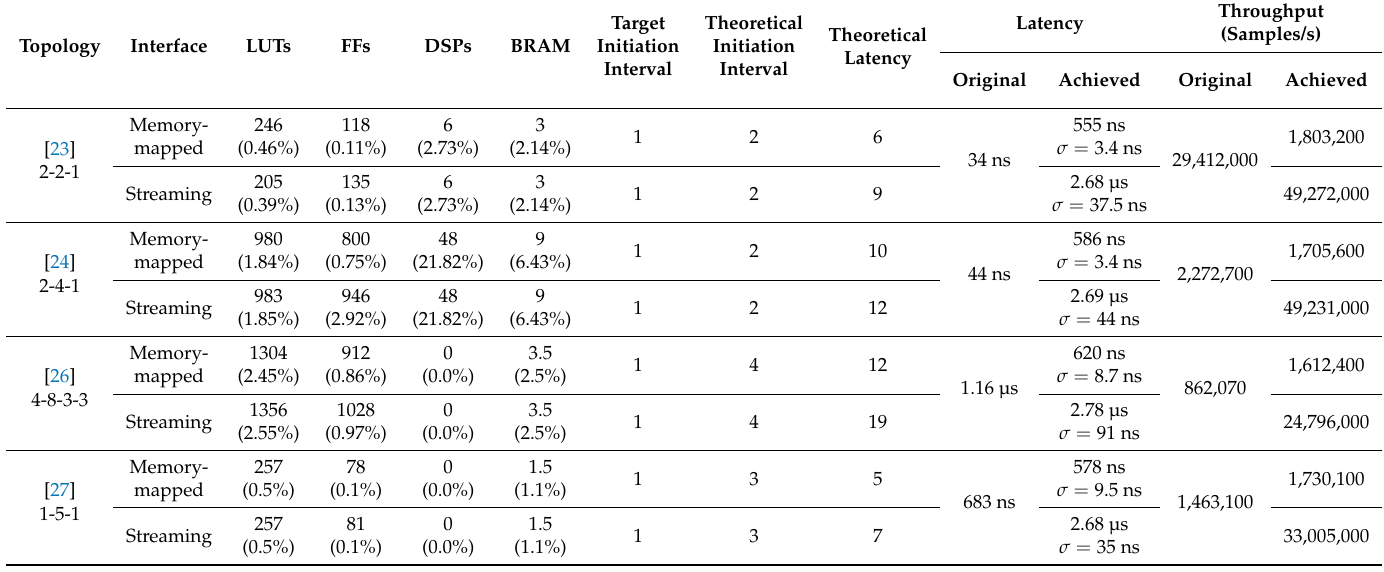
Table 2. Implementation resource use and benchmark result comparison table with